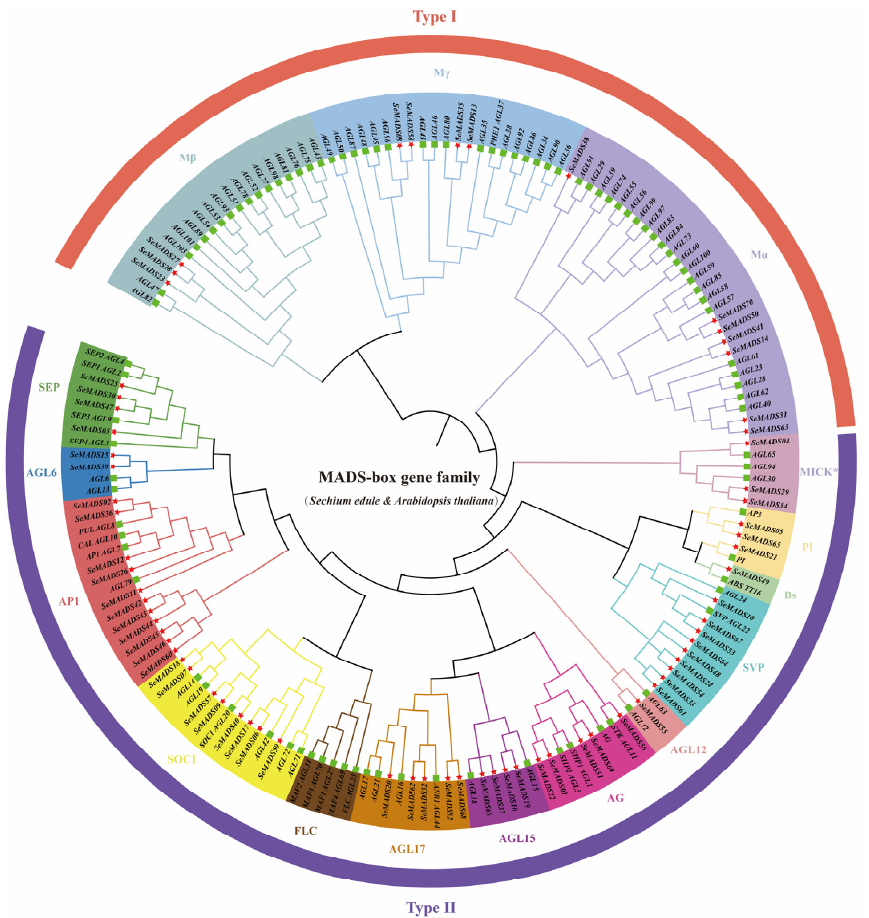
Figure 1. Phylogenetic tree based on the MADS-box proteins of S. edule and Arabidopsis . Different colors are used to distinguish fifteen subfamilies. The red star and the green square indicate S. edule and Arabidopsis , respectively.